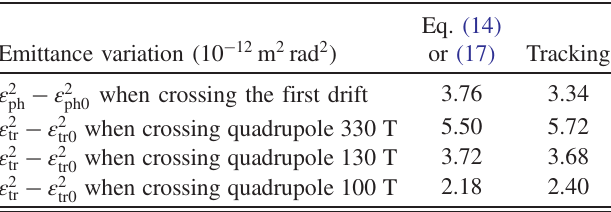
TABLE I. Emittance variation through the first drift or through the quadrupole, given by the formulas or the particle tracking.